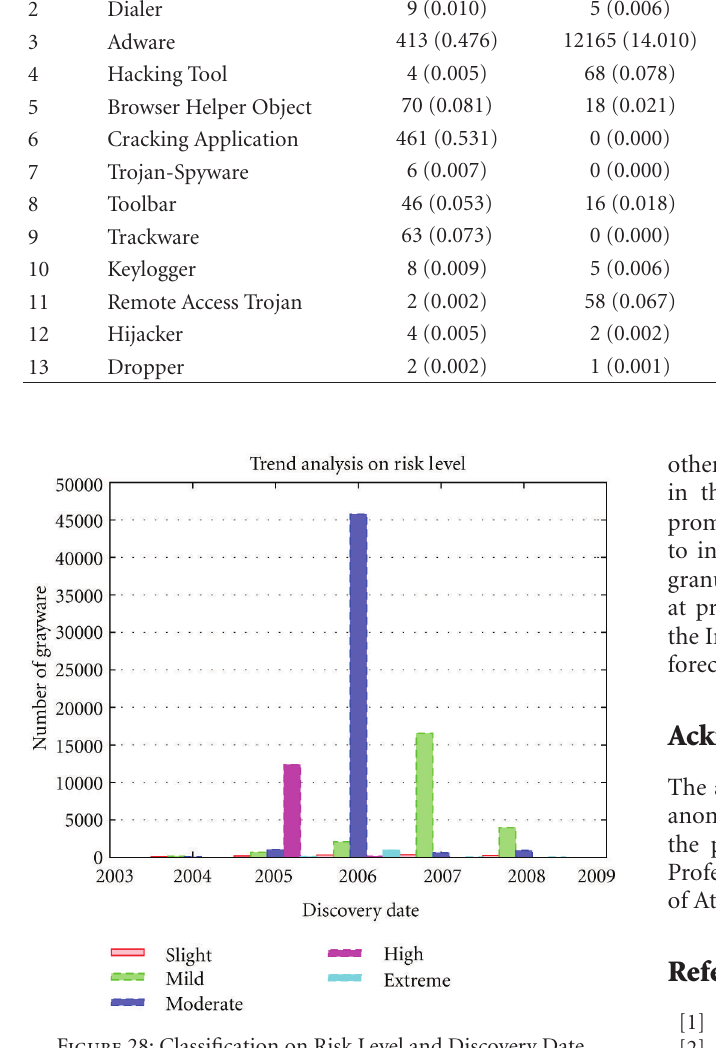
Figure 28: Classification on Risk Level and Discovery